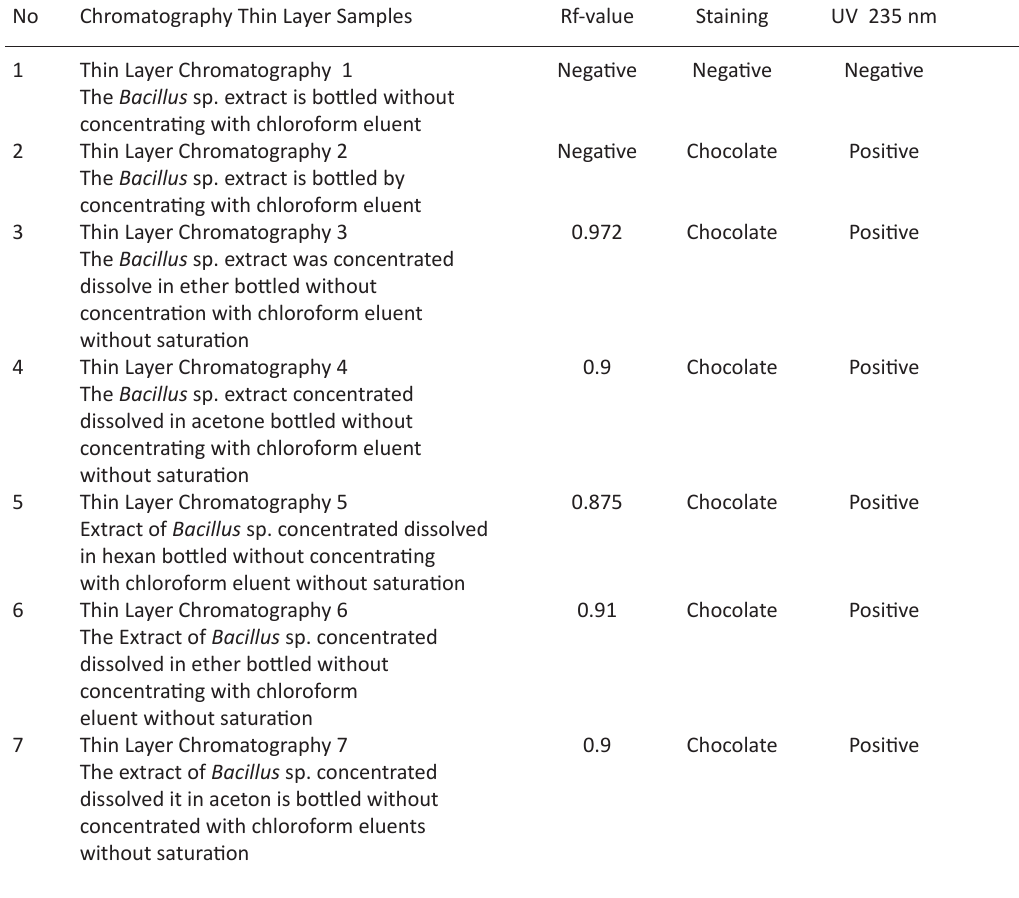
No Chromatography Thin Layer